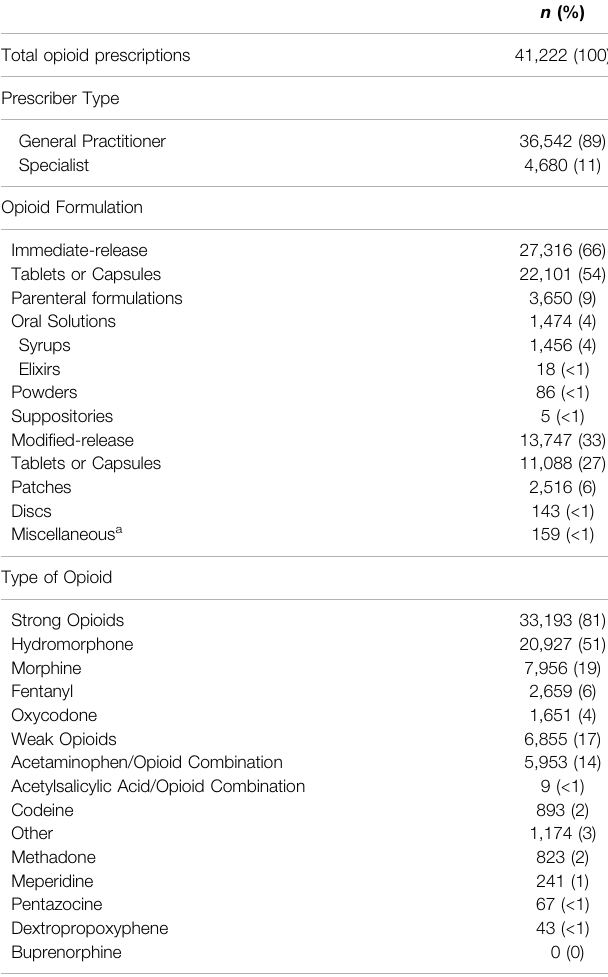
TABLE 2 | Pro fi le of opioid dispensations dispensed to the end-of-life cancer study population that was linked to the Nova Scotia Prescription Monitoring Program from 2005 –